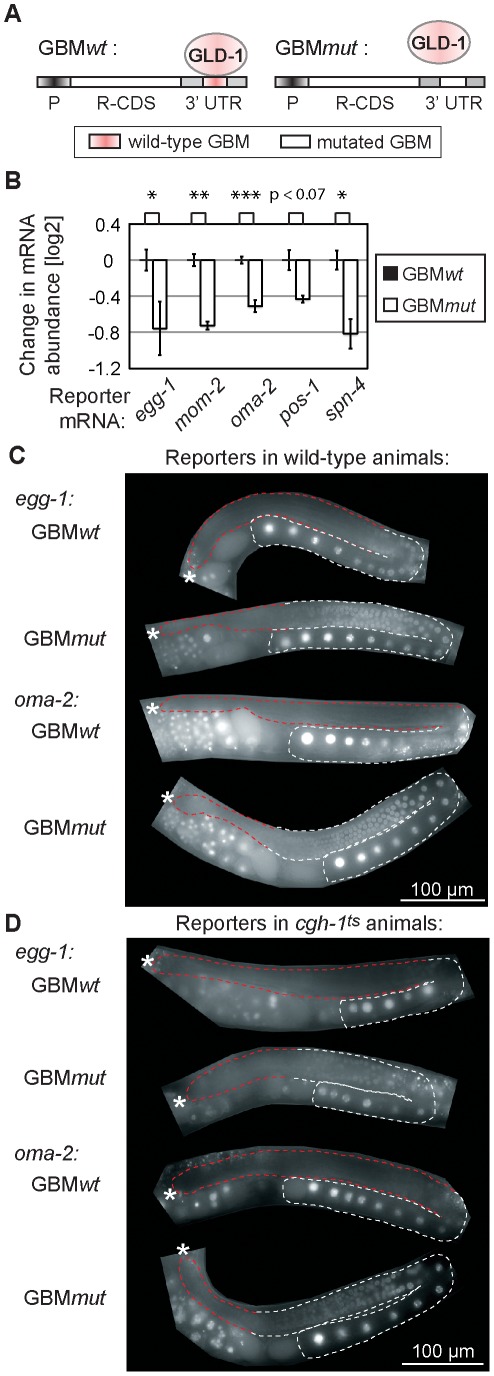
GLD-1 binding elicits mRNA stabilization and translational repression.(A) Schematic of reporters that were used to test the effect of GLD-1 binding motifs (GBMs) on mRNA stability and translation. P: a germ line-specific promoter (mex-5); R-CDS: reporter's coding sequence consisting of GFP fused to histone H2B; 3′UTR: GLD-1 target 3′ UTR containing either wild-type GBMs (GBMwt), or mutated GBMs (GBMmut) that no longer recruit GLD-1. (B) Mutating GBMs reduced mRNA levels of several reporters (shown is one reporter line per construct, for additional lines see S5A). Reporter mRNA levels were analyzed by RT-qPCR and normalized to tbb-2 mRNA. Shown are mRNA level changes of GBMmut reporters relative to GBMwt reporters. One asterisk indicates p<0.05, two asterisks p<0.01, and three asterisks p<0.001 (p values were calculated with a t test). (C) Mutating GBMs caused egg-1 and oma-2 reporter de-repression in the medial gonad. Shown are photomicrographs of gonads (outlined; red highlighting repressed regions) from live, transgenic, and otherwise wild-type animals. (D) The same reporters were not (or additionally) de-repressed when crossed into cgh-1ts mutants. See also Figure S5B–S5C.